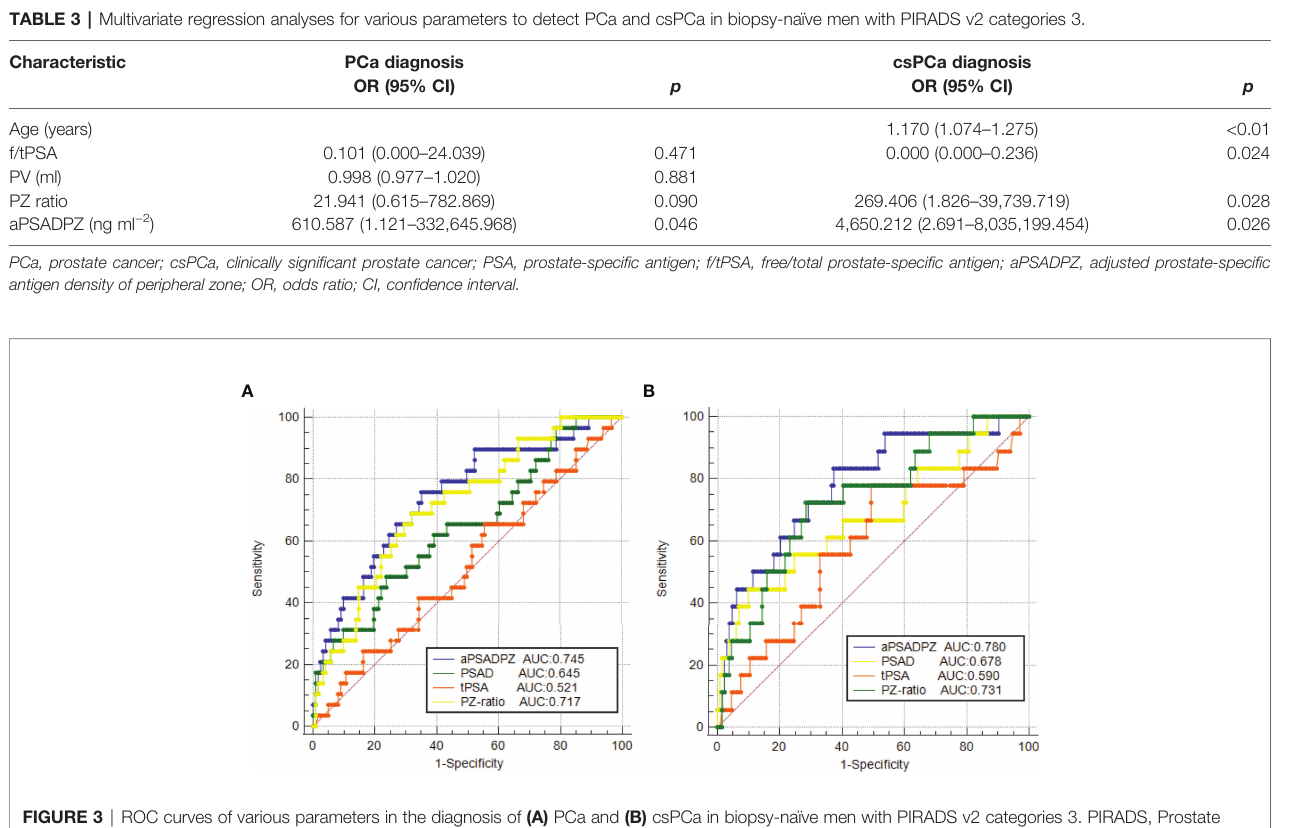
FIGURE 3 | ROC curves of various parameters in the diagnosis of (A) PCa and (B) csPCa in biopsy-naïve men with PIRADS v2 categories 3. PIRADS, Prostate Imaging Reporting and Data System; tPSA, total prostate-speci fi c antigen; PSAD, prostate-speci fi c antigen density; aPSADPZ, adjusted prostate-speci fi c antigen density of peripheral zone; PZ ratio, peripheral zone ratio; PCa, prostate cancer; csPCa, clinically signi fi cant prostate cancer; ROC, receiver operating characteristic; AUC, area under the curve.